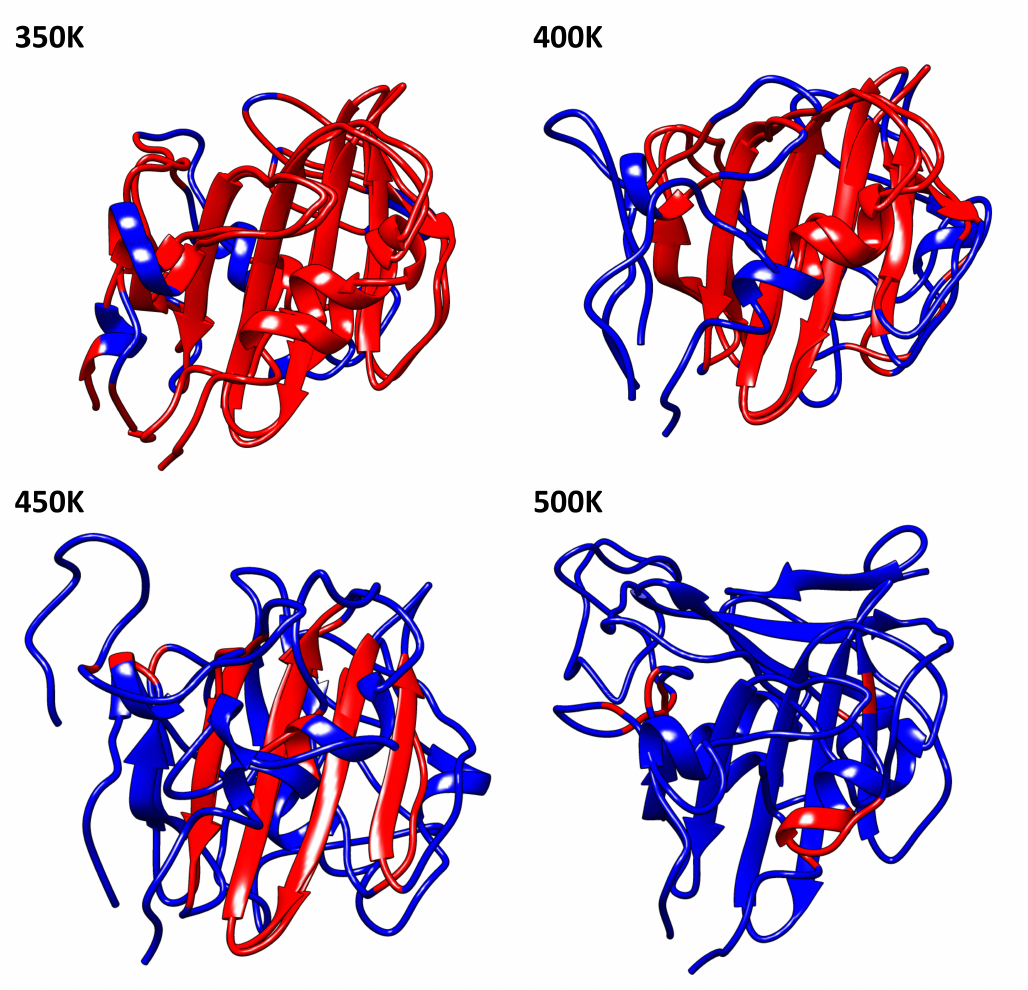
Figure 4. Molecular structure comparison of 300 K between 350 K, 400 K, 450 K, and 500 K, the red color show us the structural conservation. For additional information of beta-sheet conformation see Table S6 of supplementary